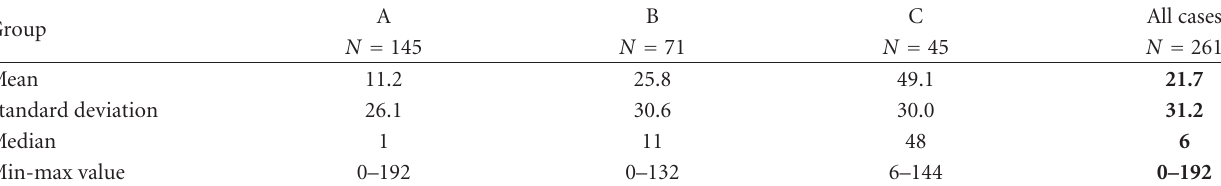
Table 2: Average values of survival time (months) after diagnosis of HIV infection in 261 of 284 autopsies of acquired immunodeficiency syndrome, in which it was possible to obtain this information, according to the study groups. A B C All cases Group N = 145 N = 71 N = 261 Mean 11.2 25.8 21.7 Standard deviation 26.1 30.6 30.0 31.2 Median Min-max value 0–192 0–132 6–144 0–192 Group A: without use of any antiretroviral medication; B: 1 or 2 antiretroviral therapy or HAART for any time less than 3 months; C: HAART for 3 months or more; min: minimum, max: maximum. N : number of cases it was possible to obtain the survival time. Kruskal-Wallis/Dunn: P < 0 . 001 when comparing all